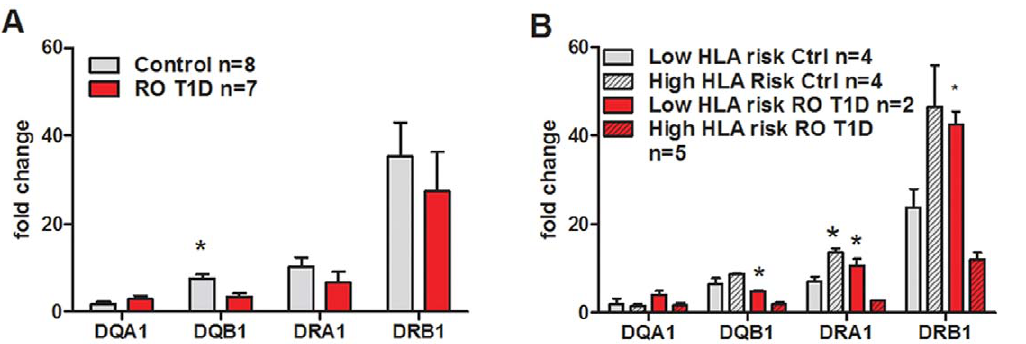
Figure 3. RT PCR verification of microarray data of HLA class II genes expression in Tregs isolated from Control and RO T1D subjects. A) HLA DR and DQ gene expression differences between control (n=8) and RO T1D (n=7) subjects. Only expression of DQB1 reached statistically significant difference (p=0.045). B) Both Control (light grey bars) and RO T1D (red bars) subjects were divided according to HLA risk (see Table S1) and compared for expression of HLA genes . While High HLA risk (cross-pattern bars) control subjects had significantly higher expression of DRA1 compared to Low risk (empty bars, Mann-U-Whitney test, p=0.045) Controls, Low HLA risk RO T1D subjects had higher expression of DRA1, but also DQB1 and DRB1 compared to corresponding High HLA risk RO T1D (Mann-U-Whitney test, p=0.03, p=0.03 and p=0.01, respectively). Values are presented with standard errors.